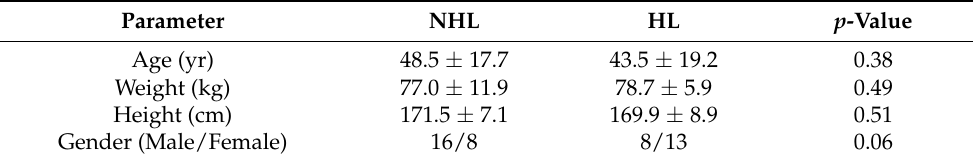
Table 5. Demographics of the 24 NHL and 21 HL patients. Data are presented as mean ± standard deviation and as numbers. Age was recorded at the time of the first PET/CT scan. p -values were estimated by the two-tailed student t -test and the chi-square test for the gender numbers. Parameter NHL